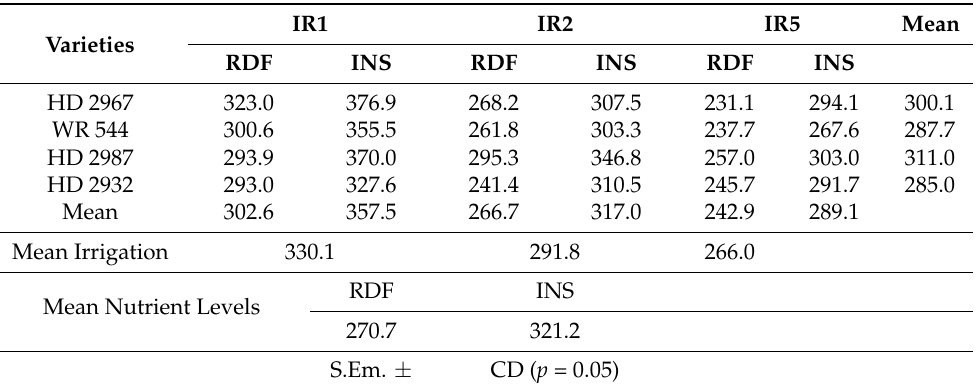
Table 3. Interaction effect of irrigation schedules and nutrient management levels and varieties on root weight (mg) 50% flowering